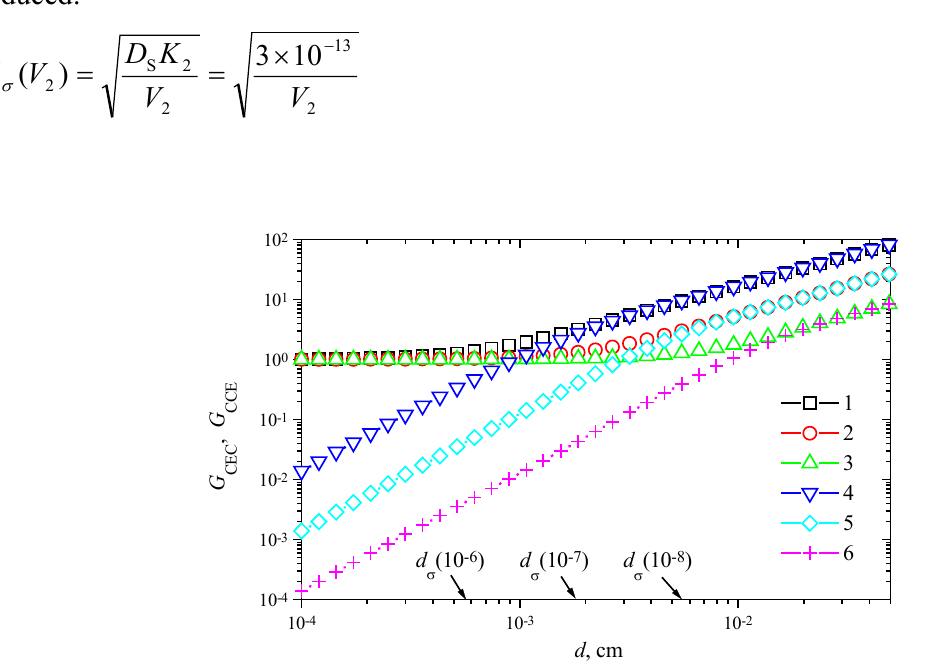
(1-3) and G (4-6) versus the membrane thickness d at three CEC CCE : 100 (1, 4), 10 (2, 5) and 1 (3, 6) nmol/(cm 3 s); V 2